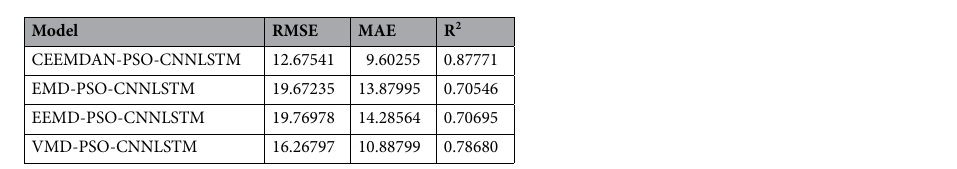
Table 2. Comparison of prediction accuracy between different